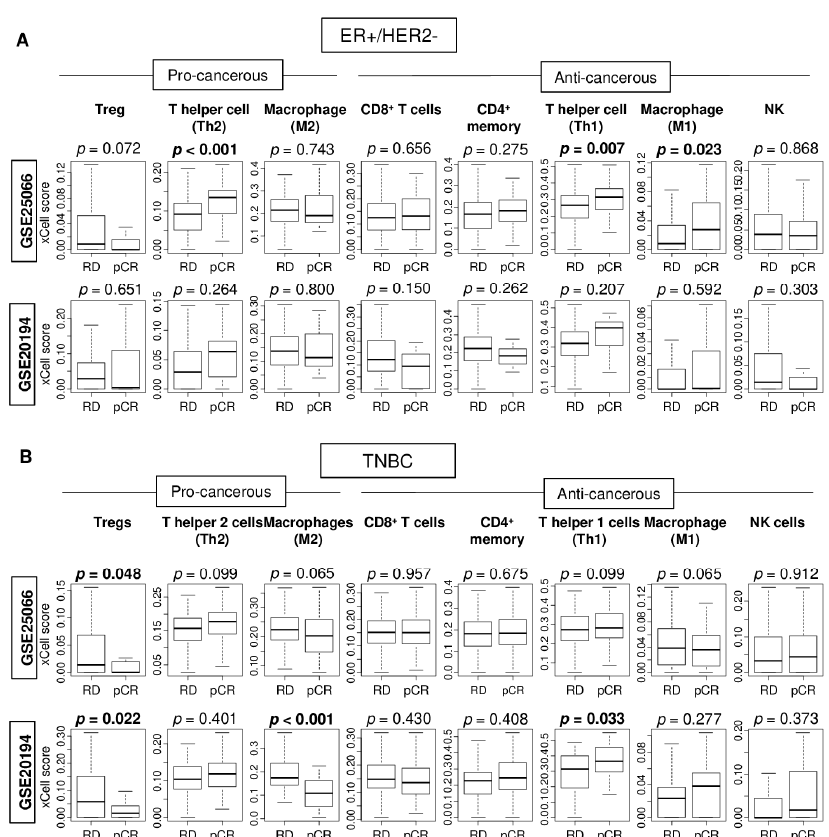
Figure 3. Association of pathological complete response (pCR) with fraction of multiple tumor infiltrating immune cells in the GSE25066 and GSE20194 cohorts. These cohorts were chosen because of their response to neoadjuvant chemotherapy data. Boxplots of levels of immune cells with residual disease (RD) and pCR after NAC in ( A ) ER-positive/HER2-negative tumors and ( B ) TNBCs in both patient cohorts. Mann–Whitney U test was used for the analysis. Pro-cancerous immune cells included Tregs, T helper type 2 cells (Th2), and M2 macrophages. Anti-cancerous immune cells included CD8 T cells, CD4 memory T cells, T helper type 1 cells (Th1), M1 macrophages, and Natural Killer T cells